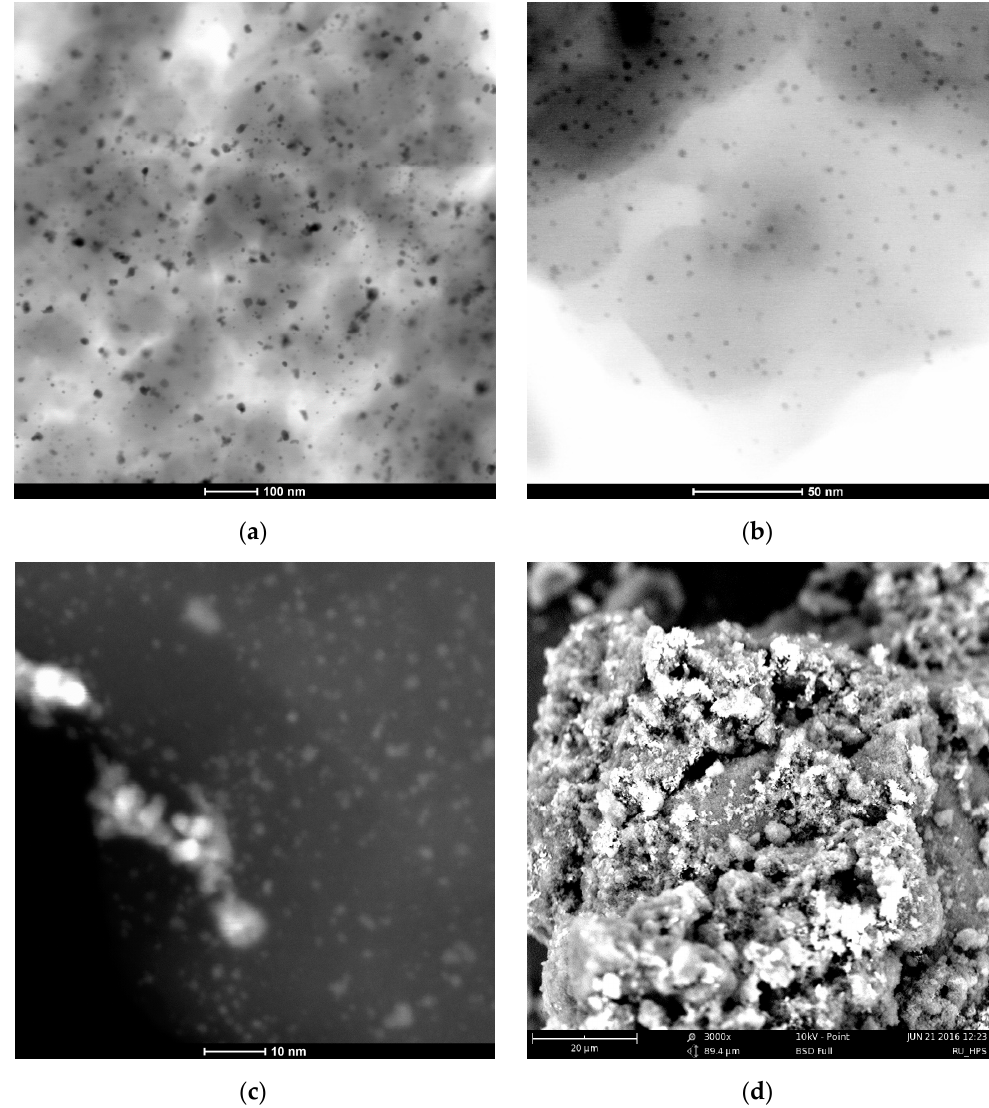
Figure 14. HAADF-STEM images of activated samples (( a ) 1% Pt/HPS-NR 2 (scale 100 nm), ( b ) 2% Pd/HPS-NR 2 (scale 50 nm), ( c ) 2% Ru/HPS-NR 2 (scale 10 nm)) and SEM image ( d ) of 2% Ru/HPS-NR 2 (scale 20 μ m).